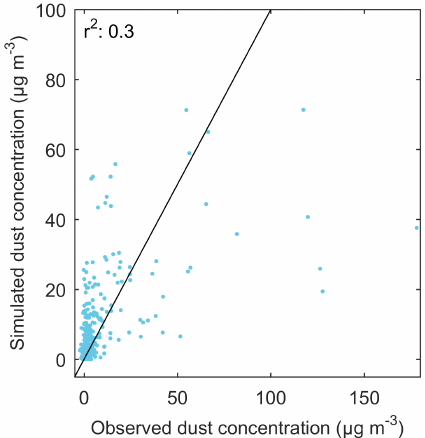
Figure 6. Weekly mean simulated vs. observed dust concentration (µgm − 3 ) at Stórhöfði/Heimaey. The black line shows where simu- lated and observed values are